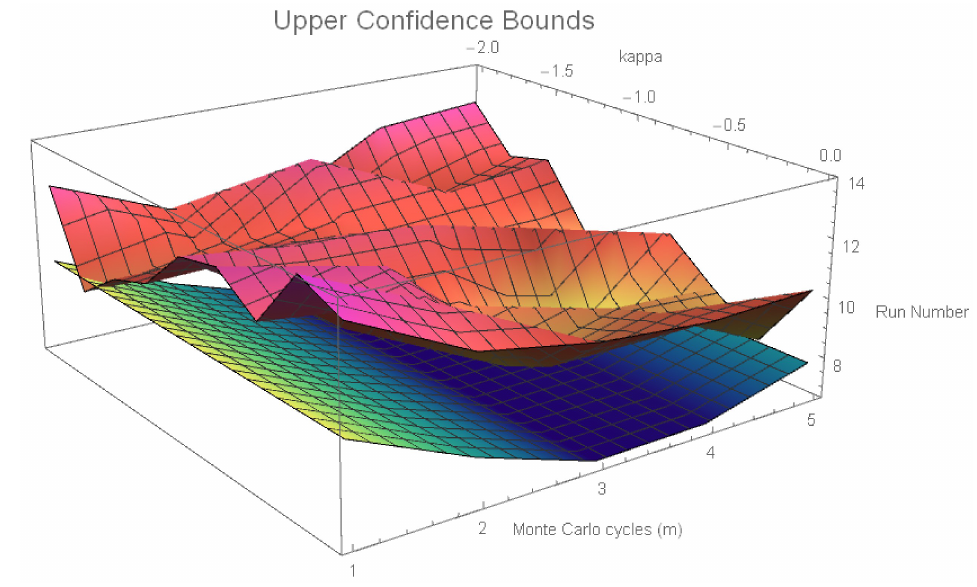
Figure 3. Upper confidence bounds: ZLCB (red-purple) and BS (blue-green) Figure 3. Upper Confidence Bounds: ZLCB (red-purple) and BS (blue-green)